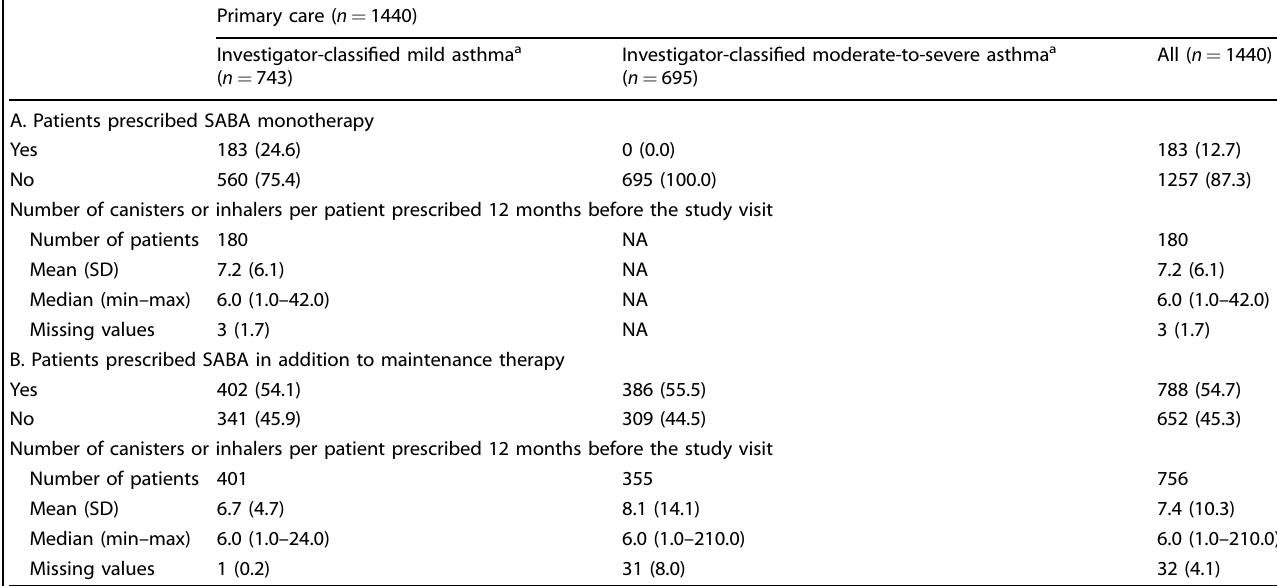
Table 3. Patients in the SABINA III PCP cohort who received prescriptions for (A) SABA monotherapy and (B) SABA in addition to maintenance therapy in the 12 months before the study